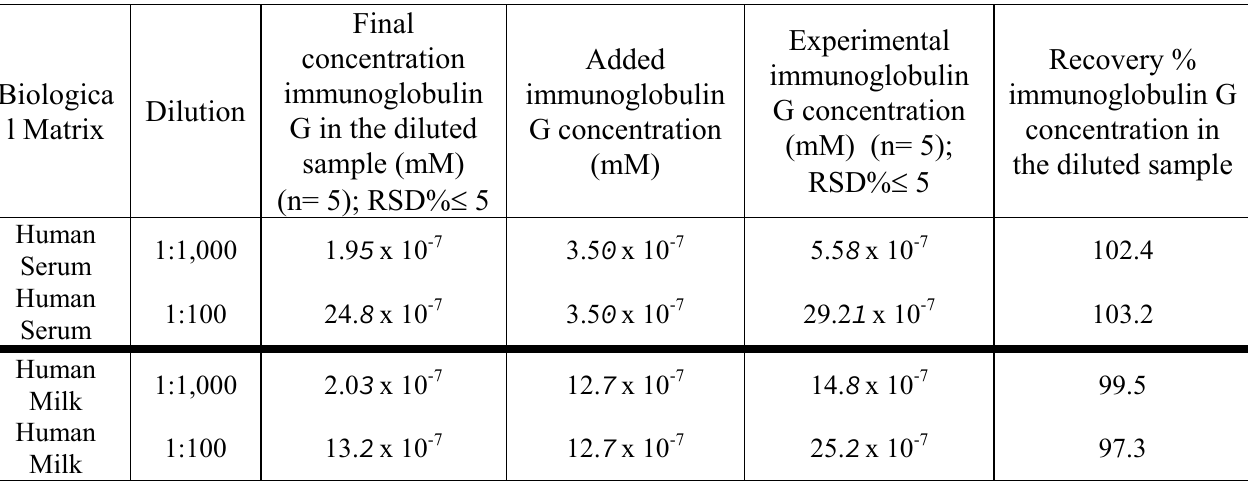
Table 7. Recovery tests by new immunosensor of added immunoglobulin G in human serum and human milk (at different